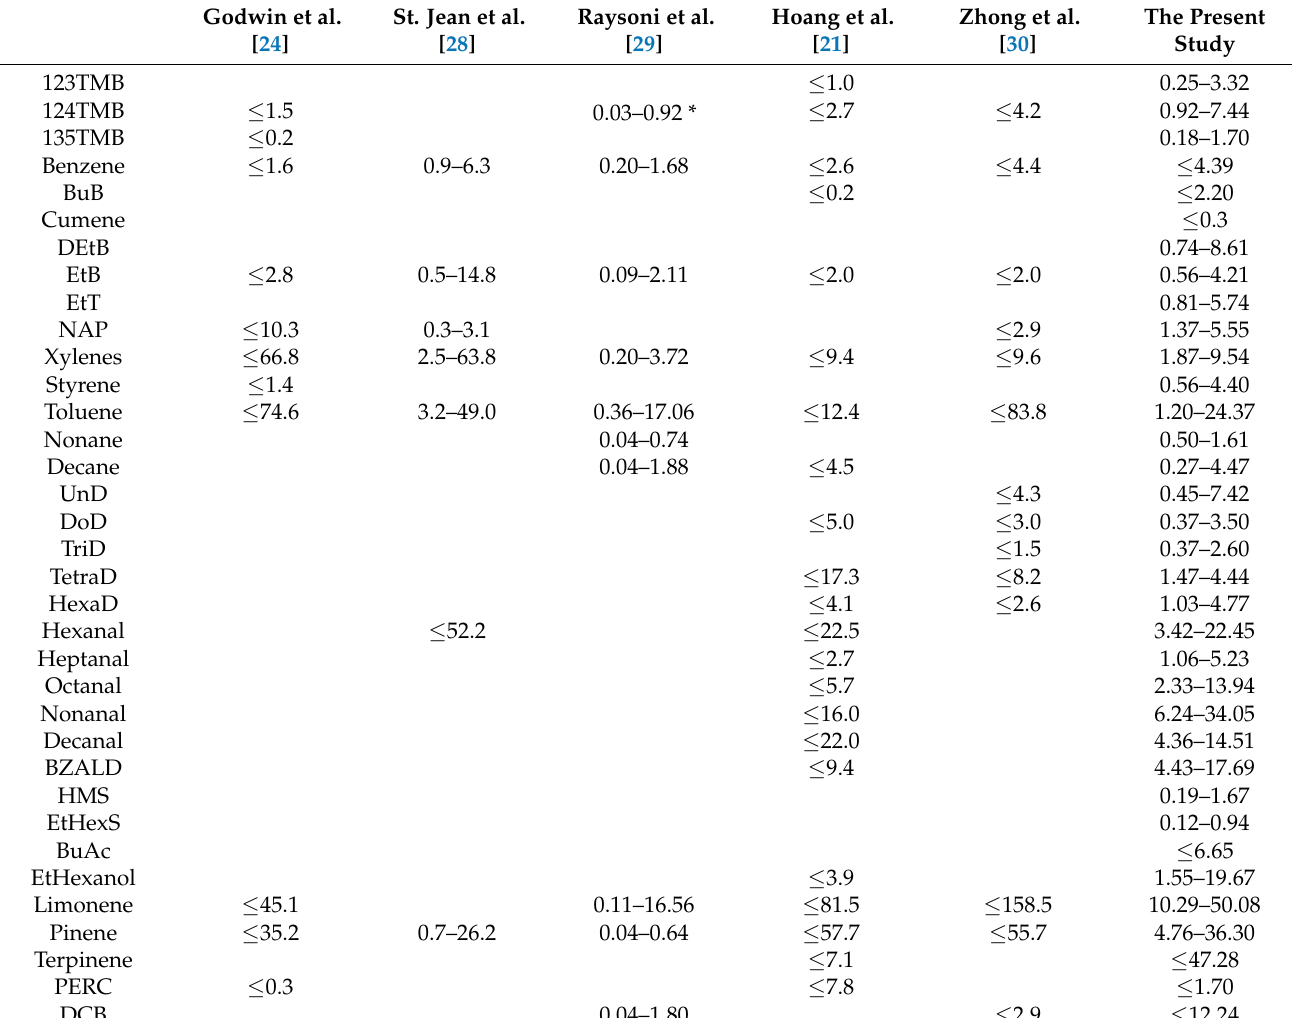
Table 1. Comparison of VOC compositions ( µ g/m 3 ) among the studies on indoor air quality of childcare centers and primary